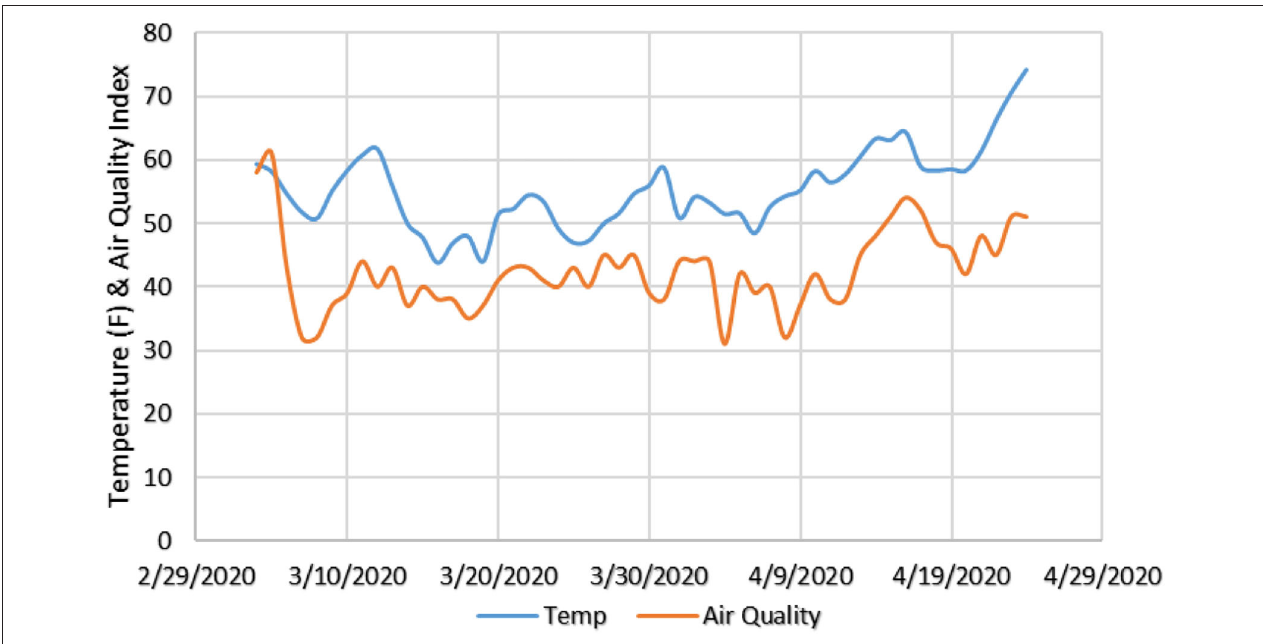
FIGURE 2 | Daily air quality index and the average temperature in California, USA.